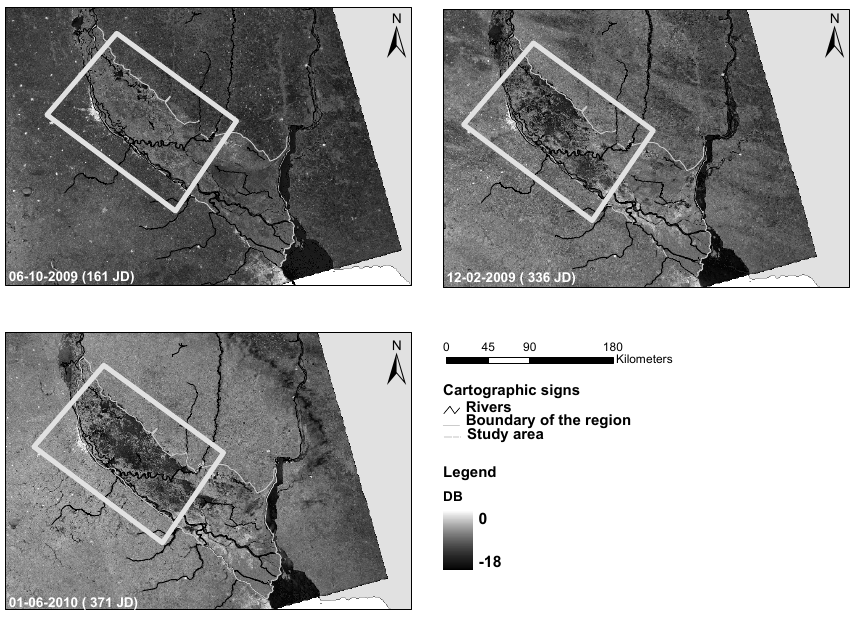
Fig. 3. Example of Envisat ASAR Wide Swath (HH polarization) images of the Paran´a River delta used in this paper. Julian dates starting from 1 January 2009: 161, 336 (upper figures), 371 (lower figure). The rectangular box indicates the area selected in this study.